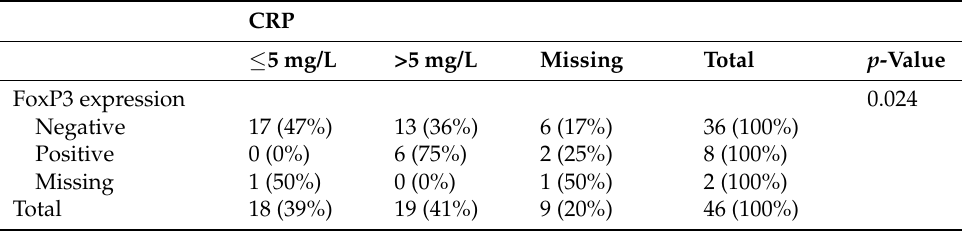
Abbreviations: FoxP3; Forkhead box protein P3; CRP, C-reactive